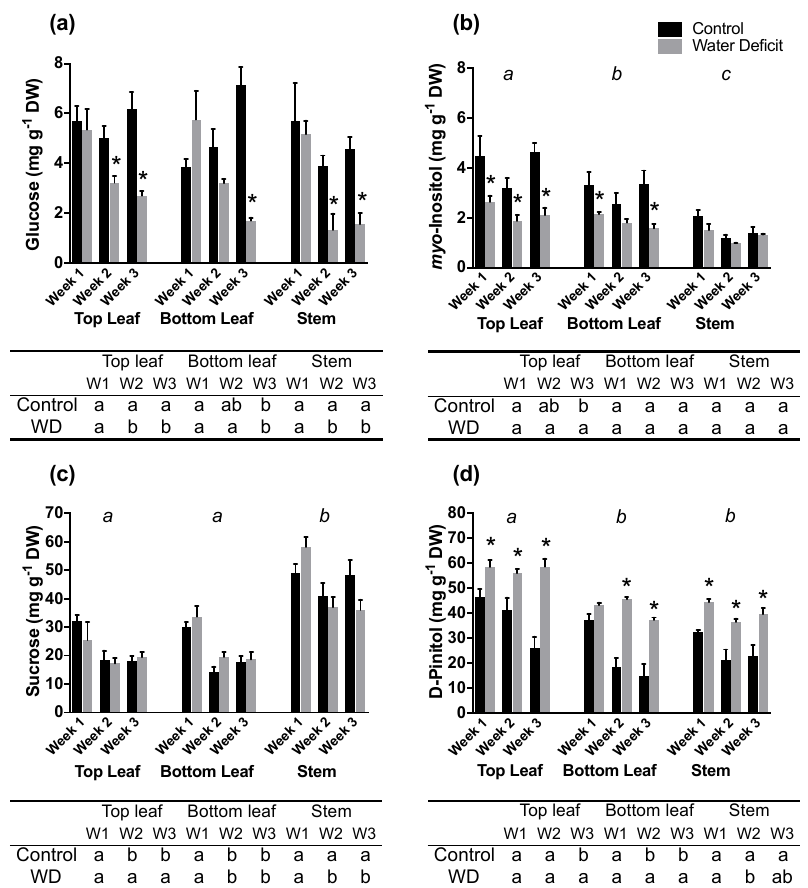
Figure 3. Average metabolite concentrations (mg g-1 DW) of glucose ( a ), myo -inositol ( b ), sucrose ( c ) and D -pinitol ( d ) in soybean leaf and stem samples subjected to well-watered control (black columns) and drought stress conditions (grey columns). Samples were collected at approximately 2 pm on the day of gas exchange measurements. Leaves located a node above (top leaf), a node below (bottom leaf) the gas exchange leaf, and the stem portion in between were harvested for this analysis. Columns denote the average concentration obtained from 4 plants. Bars represent the standard error from the mean ( n = 4). Letters displayed above histogram denote significant ( p < 0.05) differences between plant organs. Asterisk (*) indicates significant difference ( p < 0.05) between control and treatment sample. Table below histogram denotes significant ( p < 0.05) differences between sampling week and treatment. Significant changes occurred in myo -inositol concentrations measured in leaf samples (Figure